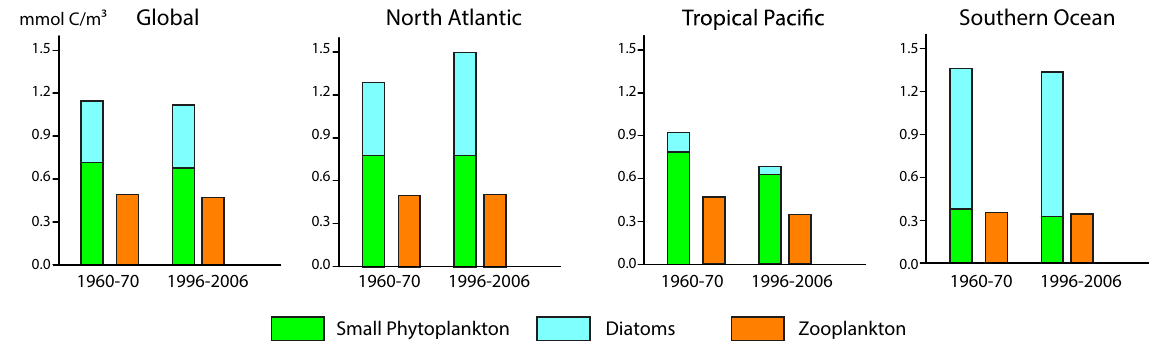
Fig. 8. Biomass structure of phytoplankton types and zooplankton at different regions. Each panel shows the biomass structure for the first ten years average (1960–1970) and for the last ten years average (1996–2006). Biomass is given as average concentration [mmolCm − 3 ] of the respective PFT for each region. The ratio between total phytoplankton and zooplankton is influenced by temperature, with higher temperatures leading to higher zooplankton quota. Moreover, diatoms can sustain a lower zooplankton biomass as the zooplankton growth rate is lower when feeding on diatoms.